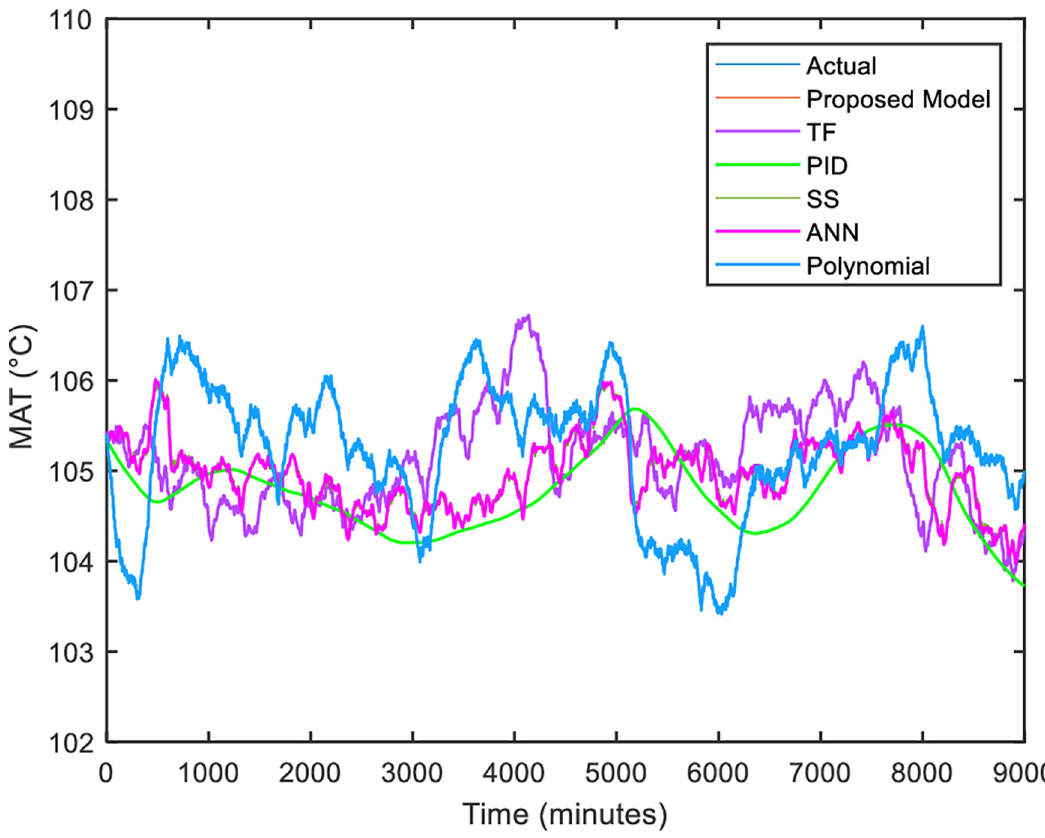
Fig 12. Comparison between actual and simulated hot air temperature, T h